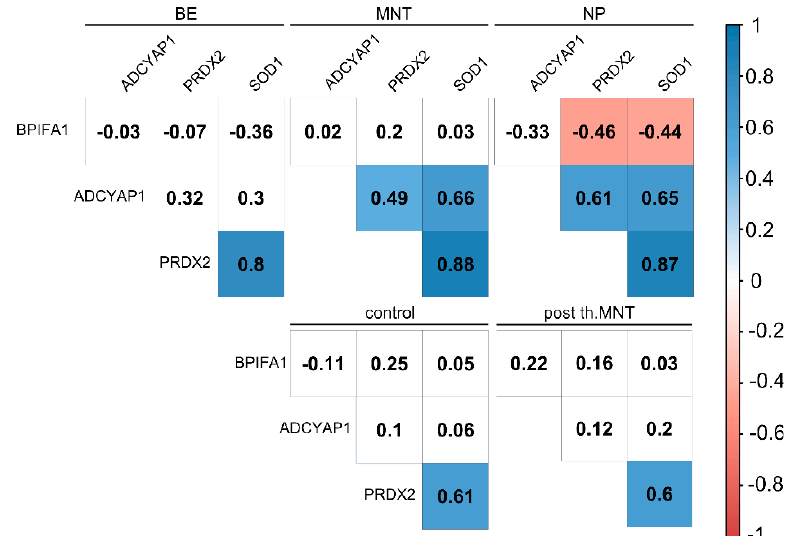
Figure 6. Correlation heatmaps depicting bulk gene expression in annotated groups (Spearman’s correlation coefficient). Significantly correlated genes are depicted by colored rectangles, whereas a blank cell denotes insignificant p -value as per level of 0.05. Sidebar depicts the correlation coeffi- cient. BE: bulla ethmoidalis, MNT: middle nasal turbinate, NP: nasal polyp, post.th: post-treatment.